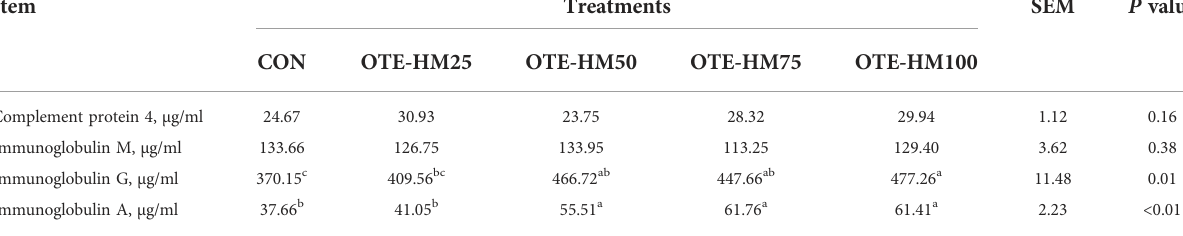
TABLE 6 Effects of experimental diets on immunological cytokine levels in serum of laying ducks 1 . Item